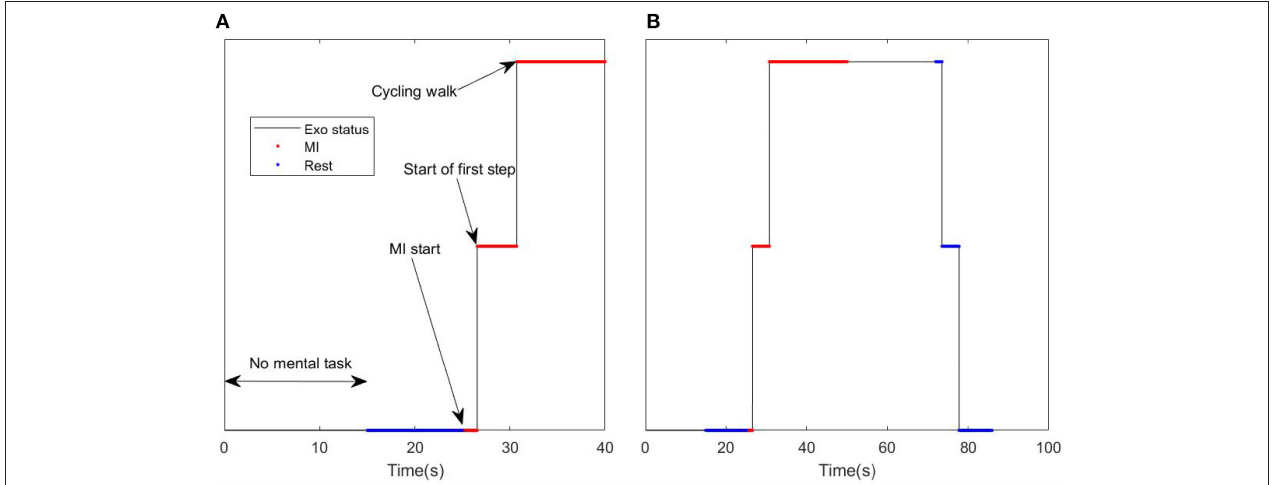
FIGURE 2 | Example of trial: (A) Details of the activation command. (B) Details of the MI tasks ∼ 20 s (red) and relaxed state event ∼ 10 + 10 s (blue), and moving reverse count (black top).